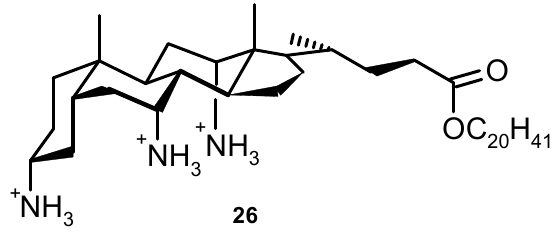
Figure 15. A novel cationic facial amphiphile